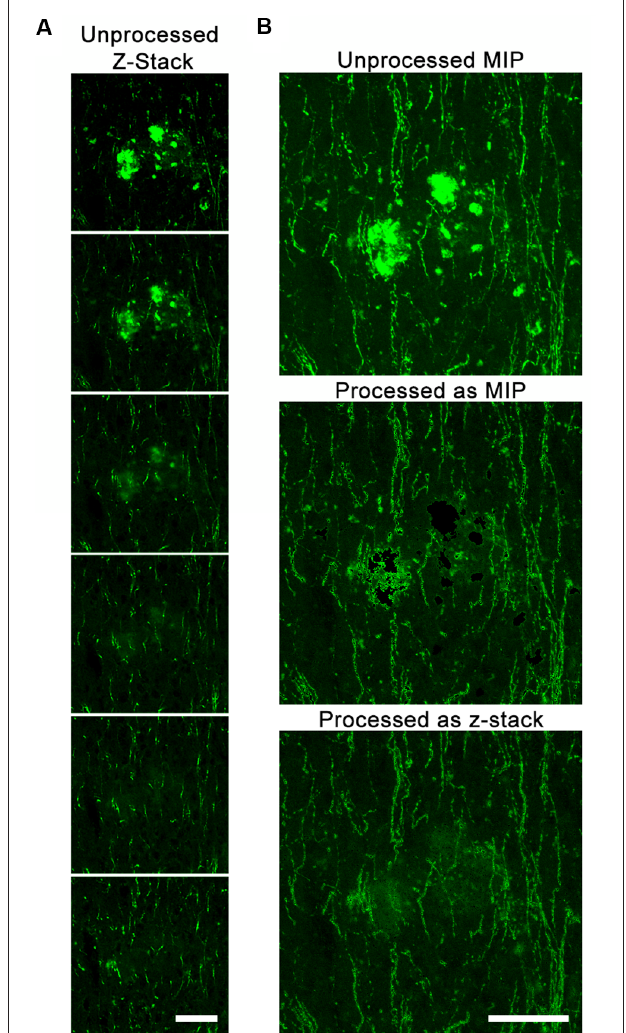
preservation of axonal fibers. (A) Individual z-slices within one z-stack image from the vertical limb of the diagonal band of Broca. Autofluorescent debris is present in the first three z-slices, and Alexa Fluor 488 enhanced green fluorescent protein (EGFP)-labeled axonal fibers are visible at the same location in the final three. (B) Maximum intensity projections (MIPs) of the unprocessed image, the image processed as a MIP, and the image processed as a z-stack. Fibers lost when processing a MIP are preserved when processing the z-stack. Scale bars: 50 µ